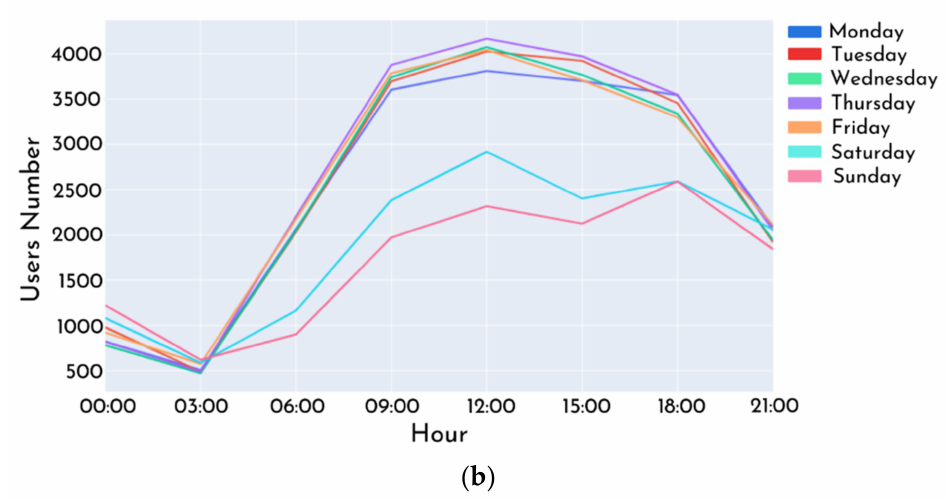
Figure 3. ( a ) The location of the 39 cell sites participating in the analysis. Blue markers show the exact location of a cell site, while green circles represent marker clusters with a number showing the number of cell sites in the vicinity of the circle’s location. Marker clusters group markers at varying zoom levels. ( b ) The mobile phone users’ number per hour and